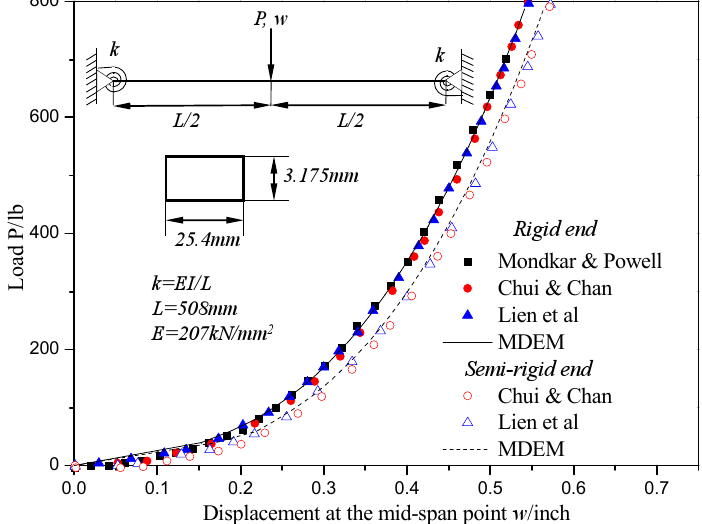
Figure 7. Displacement at the mid-span point of the beam under static loading.